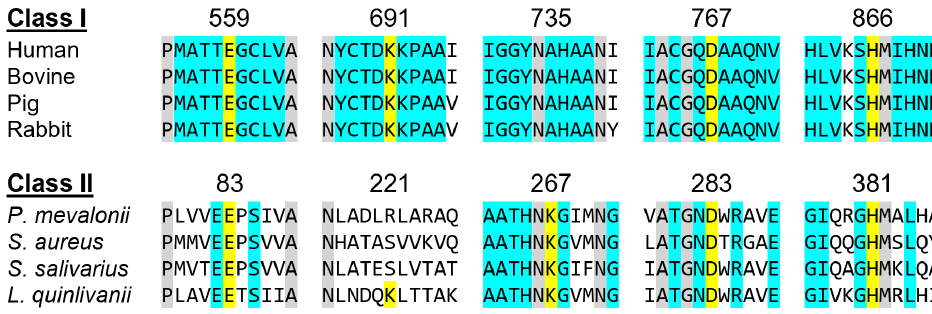
Figure 5. HMGCRs sequence alignment around the main catalytic residues, which are highlighted in yellow. The numbering is related to the human enzyme for Class I and with the Pseudomonas mevalonii one for Class II. Residues colored in grey are conserved between classes and those colored in light blue are conserved within the same